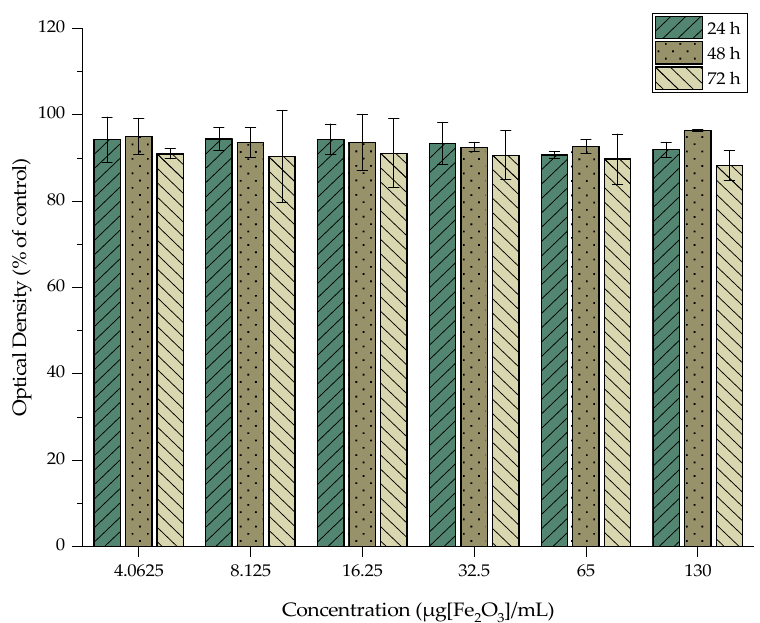
Figure 9. MTT assay of MA against the 4T1 cell line after 24, 48, and 72 h. Mean values ( n = 3) and the SD (bars) are shown (x axis not in scale).